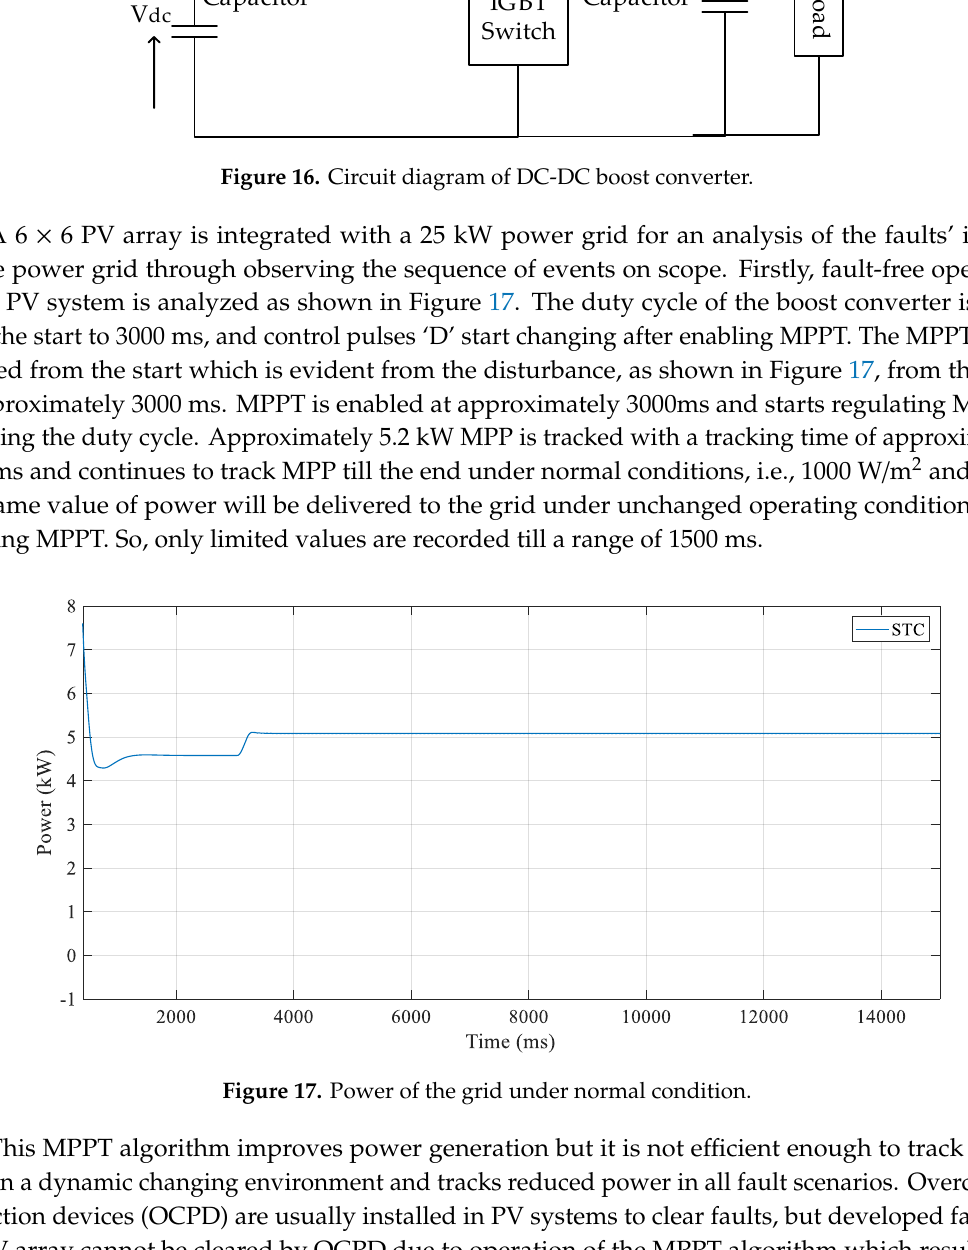
Figure 16. Circuit diagram of DC-DC boost converter.